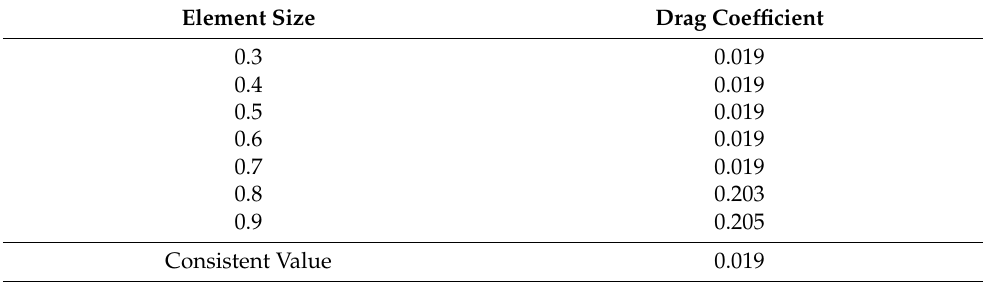
Table 1. Grid refinement